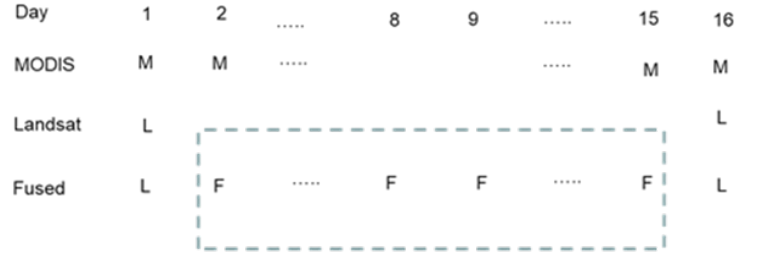
Figure 11. Fusion of Landsat and MODIS images to create a high spatial and high temporal resolution image sequence.